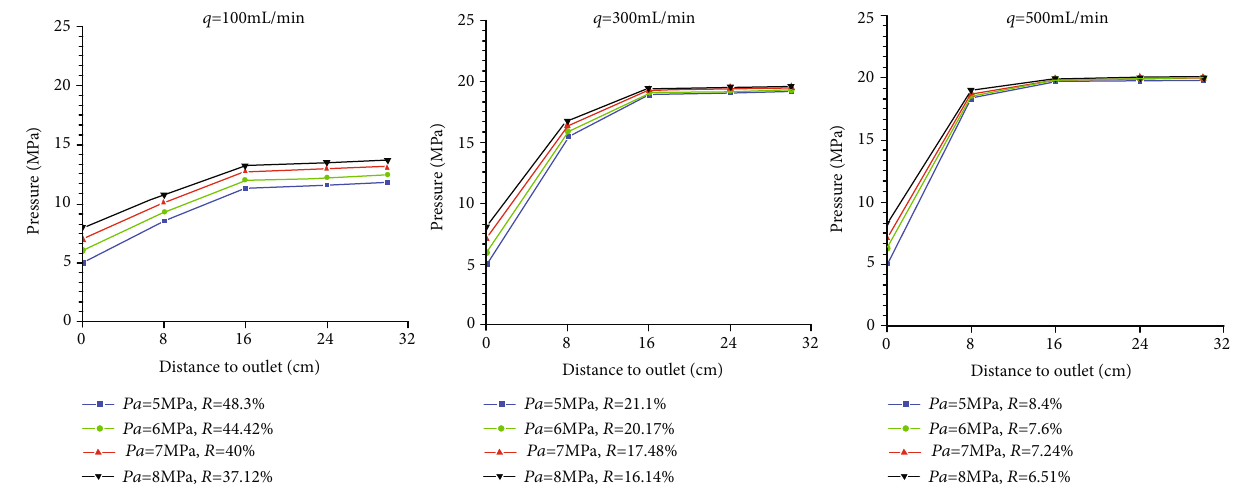
Figure 8: Drawdown curves of Su 3 under di ff erent abandonment